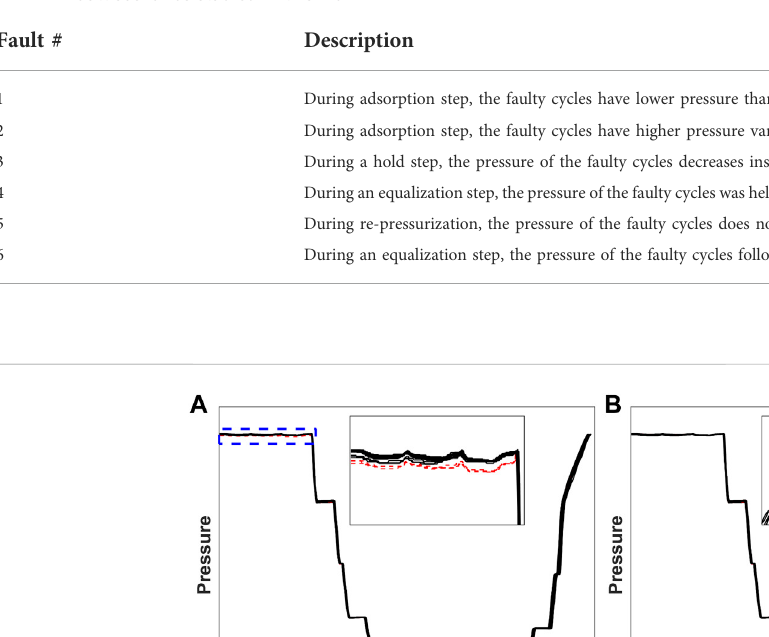
TABLE 1 Fault scenarios studied in this work.